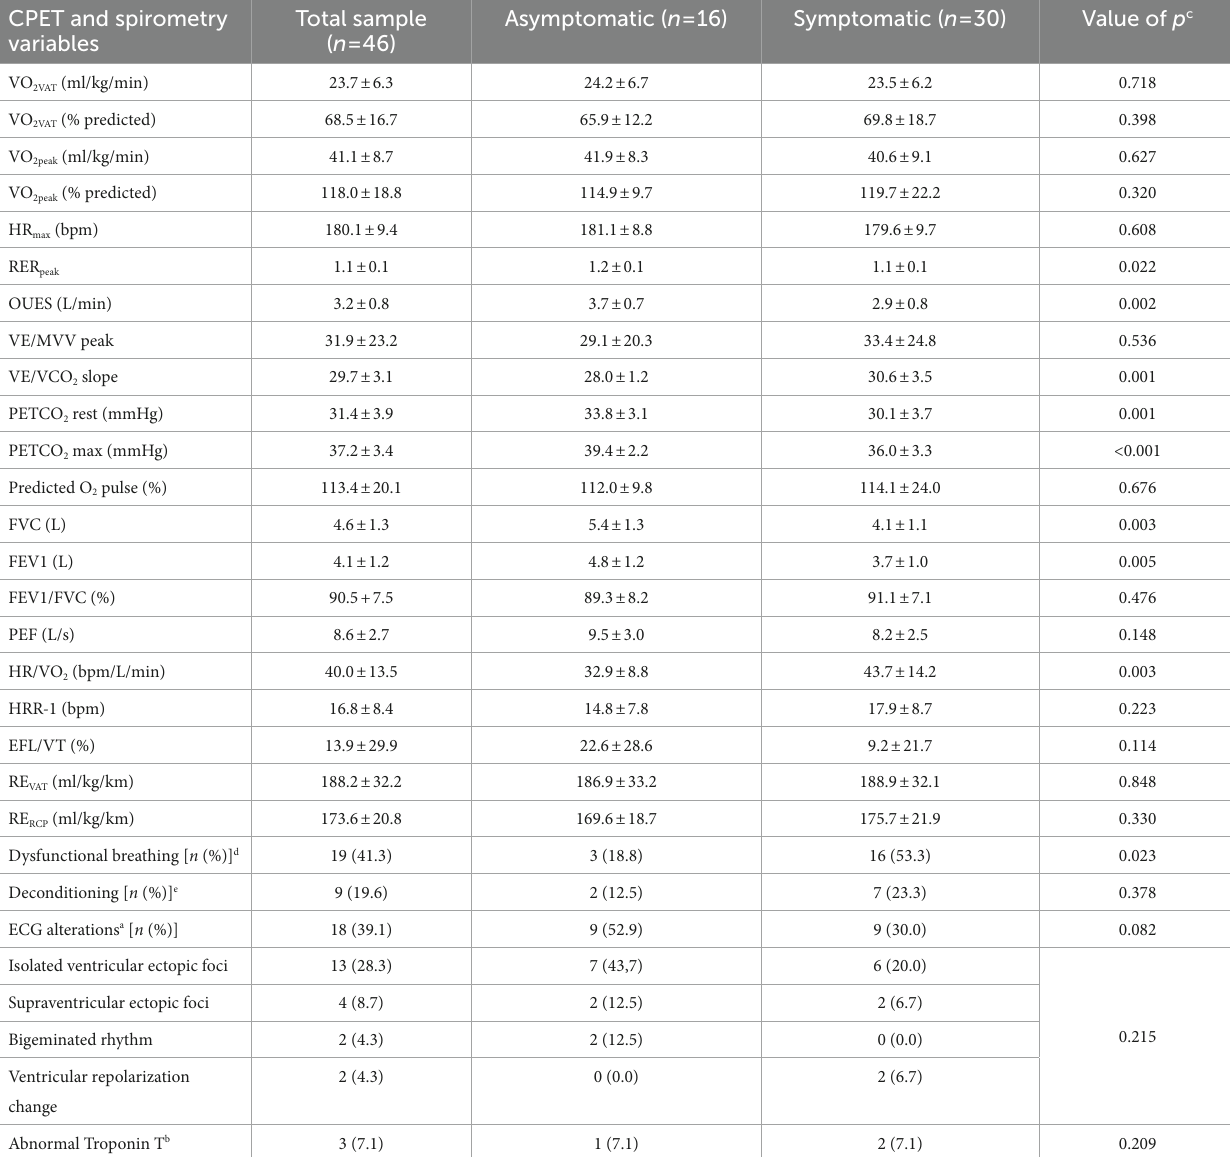
TABLE 2 CPET and spirometry variables according to the presence of cardiopulmonary persistent symptoms. CPET and spirometry